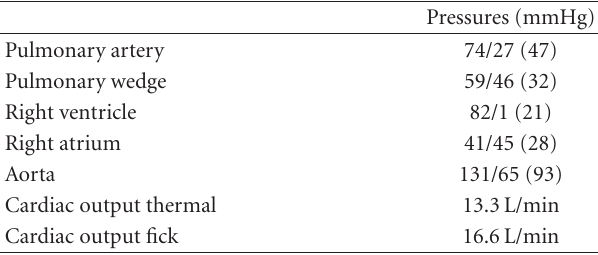
Table 1: Hemodynamic measurements during diagnostic cardiac catheterization (pressures in mmHg and cardiac output in L/min).